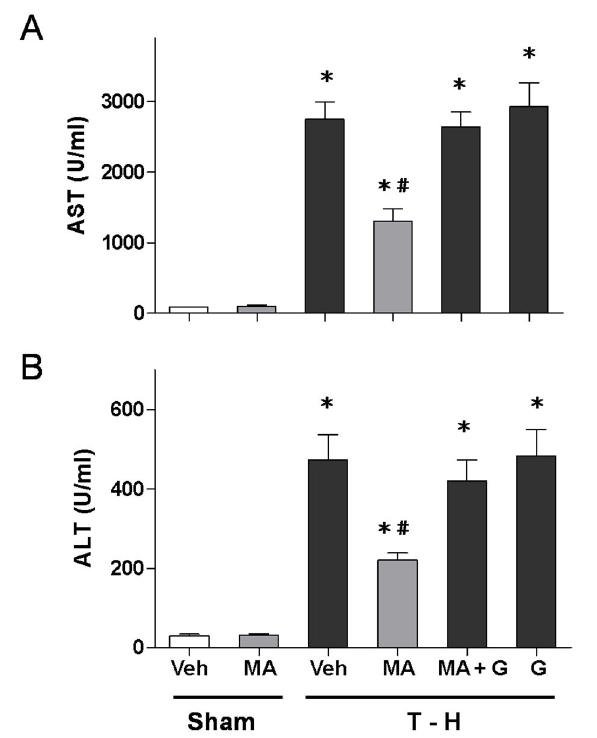
Figure 2. Effect of maraviroc treatment on plasma AST (A) and ALT (B) in rats at 24 hours after sham operation (Sham) or trauma-hemorrhage and resuscitation (T- H). Animals were treated with either vehicle (Veh), maraviroc (MA), maraviroc in combination with GW9662 (MA+G) or GW9662 (G). Data are shown as mean ± SEM of 8 rats in each group. * p <0.05 compared to Sham; # p <0.05 compared to T-H +Veh, T-H+MA+G and T-H+G.